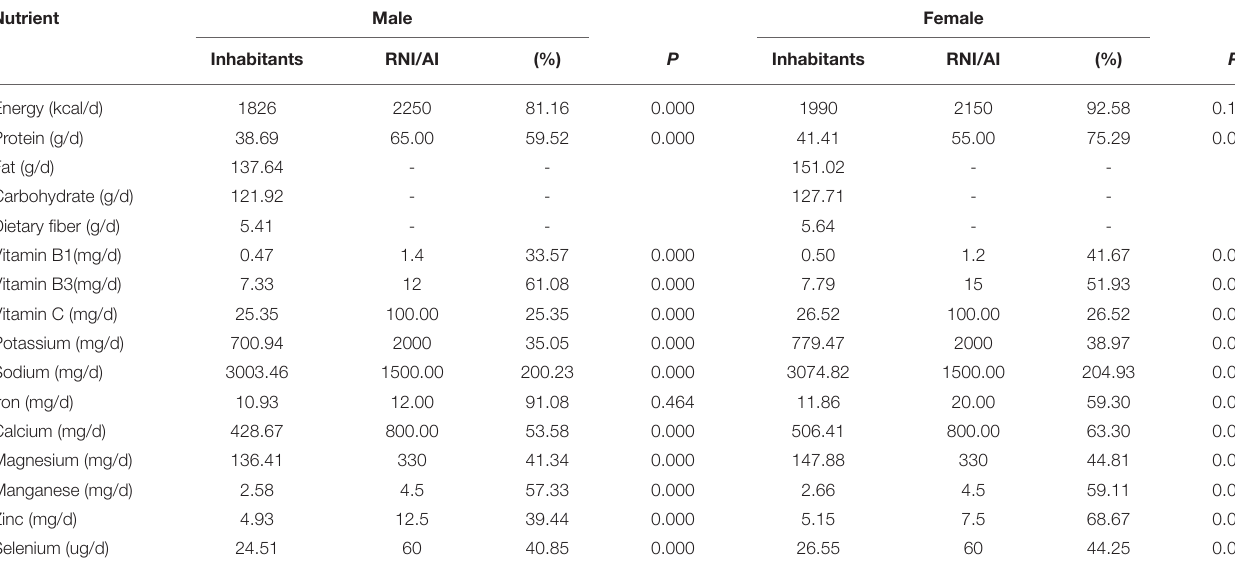
TABLE 3 | Daily nutrient intakes of inhabitants in high altitude compared with recommended nutrient intake (RNI) or adequate intake